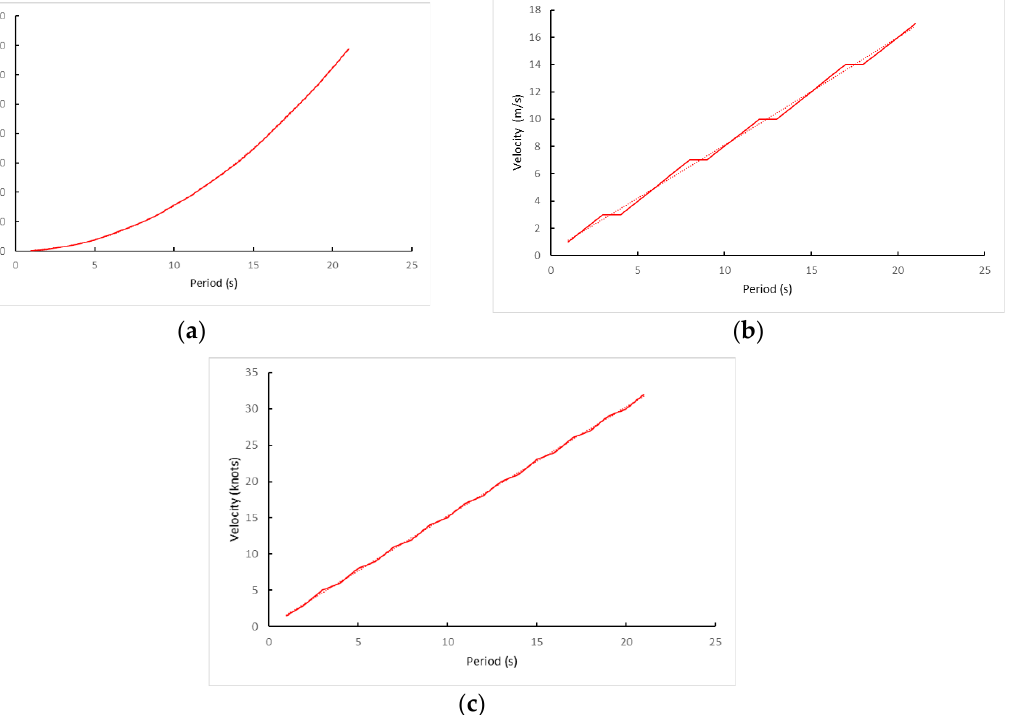
Figure 1. ( a ) Wavelength as a function of period. Precision 100%. ( b ) Velocity in m·s −1 as a function of period. Precision 99.67%. ( c ) Velocity in knots as a function of period. Precision 99.93%. Table 1. Data of studied